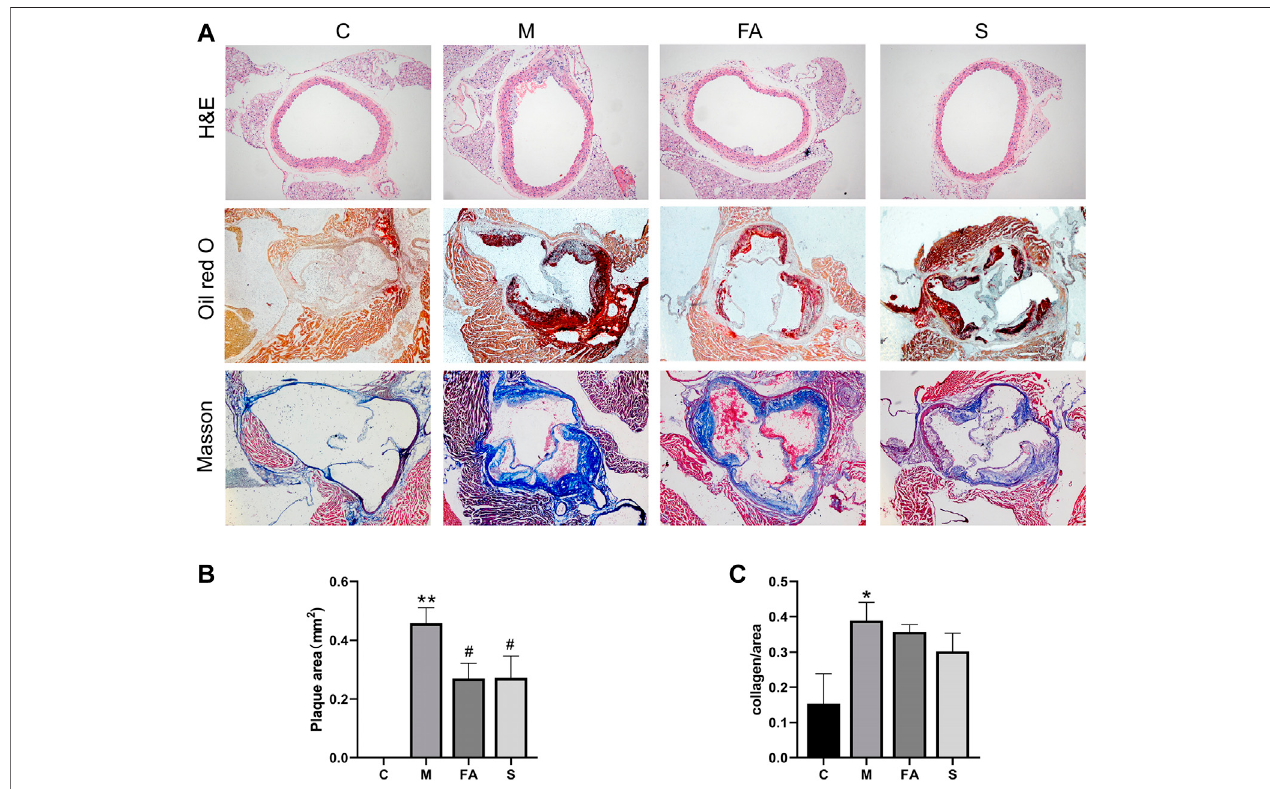
FIGURE2| FA reducedatherosclerosis injuryin ApoE − / − mice (A) H&Estainingofaorta (100 × ),OilRed Oand Massonstainingofaortic root (40 × ). (B) Quantitative analysis of plaque area in aortic root ( n (cid:2) 3). (C) Quantitative analysis of collagen fi bers in aortic root ( n (cid:2) 3). * p < 0.05, ** p < 0.01; as compared to the control group. # p < 0.05; as compared to the model